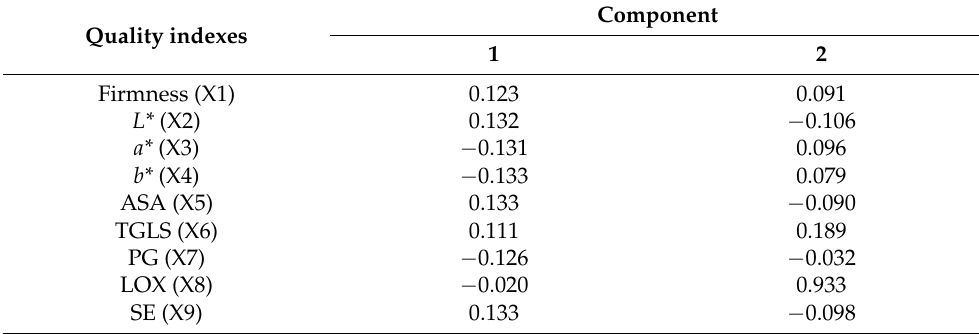
Table 6. Quality component coefficient matrix of fresh-cut “Xuebai” cauliflower florets.